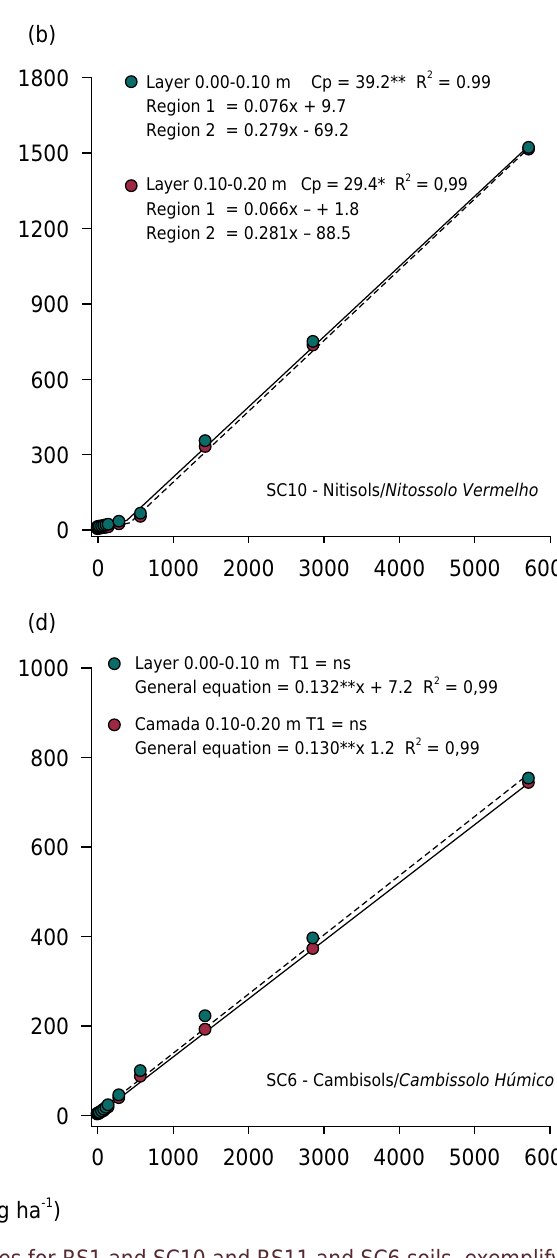
Figure 2. Phosphorus content by Mehlich-1, due to the addition of P rates for RS1 and SC10 and RS11 and SC6 soils, exemplifying soils with and without the significance of segmental equations. Cp: P Mehlich 1, in which the change point occurs between the segmented equations. **: significant at 1 % probability of error. *: significant at 5 % probability of error. NS: not significant. Note: scales are different among